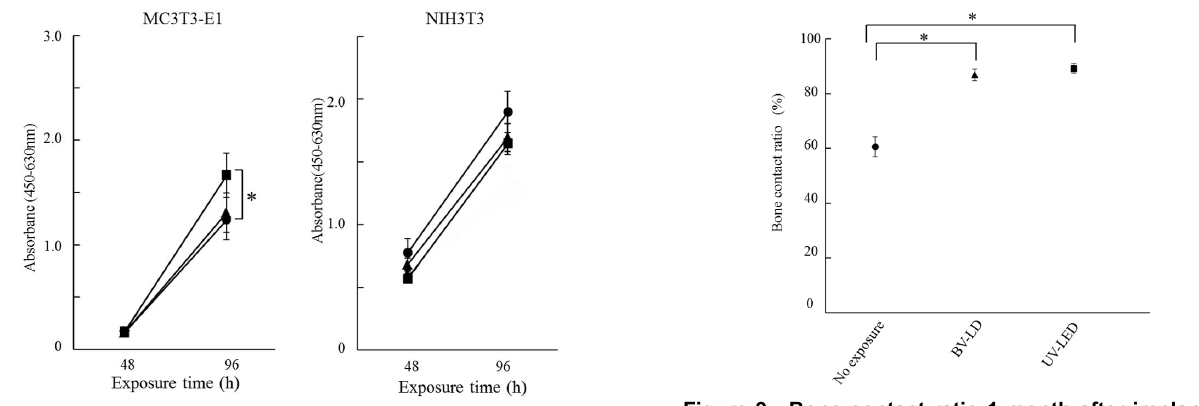
Figure 9. Bone contact ratio 1 month after implantation of titania-treated specimens.